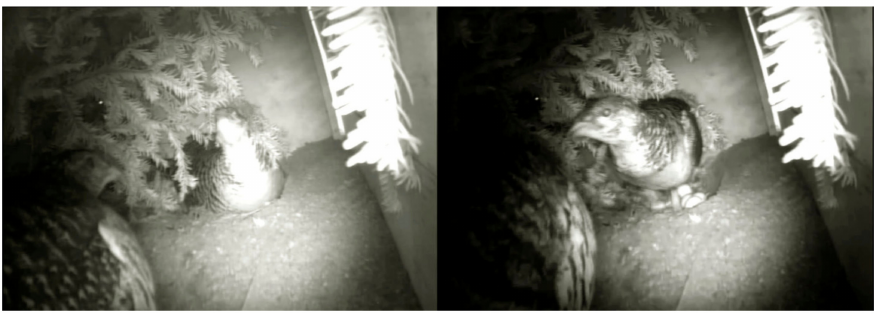
Figure 5. Threatening attitude (TA) of nesting female turns into an attack on the nest intruder